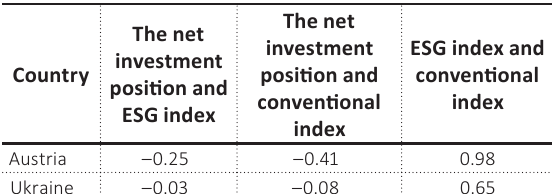
Table 3. Analysis of correlations: the